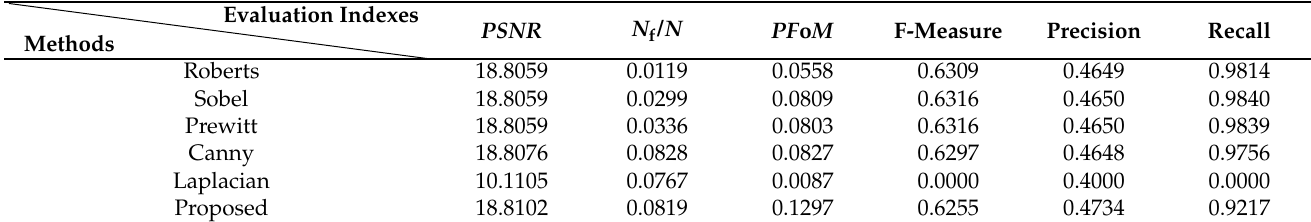
Table 1. The evaluation indexes scores of multiple edge detection methods for the visible image.